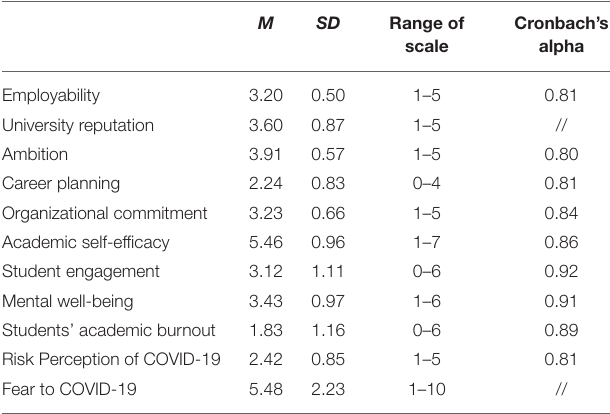
TABLE 2 | Descriptive statistics ( N =